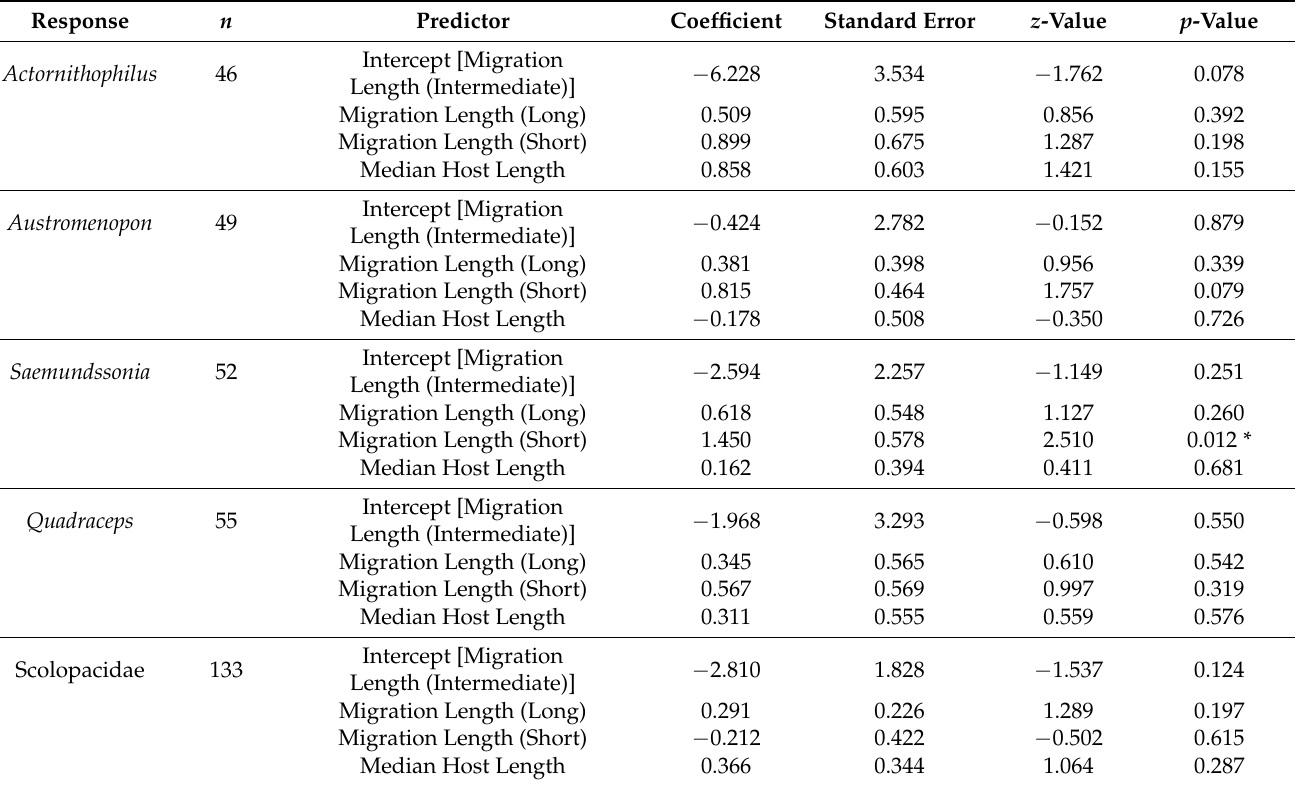
Table 10. Summary of GLMM of the effects migration length and host length on the prevalence of lice. An asterisk (*) designates the only statistically significant value.